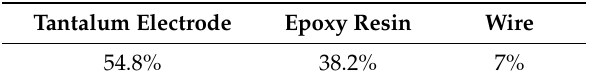
Table 1. Mass ratio of each component in the epoxy-coated solid electrolyte tantalum capacitors (EcSETC) (wt.%).